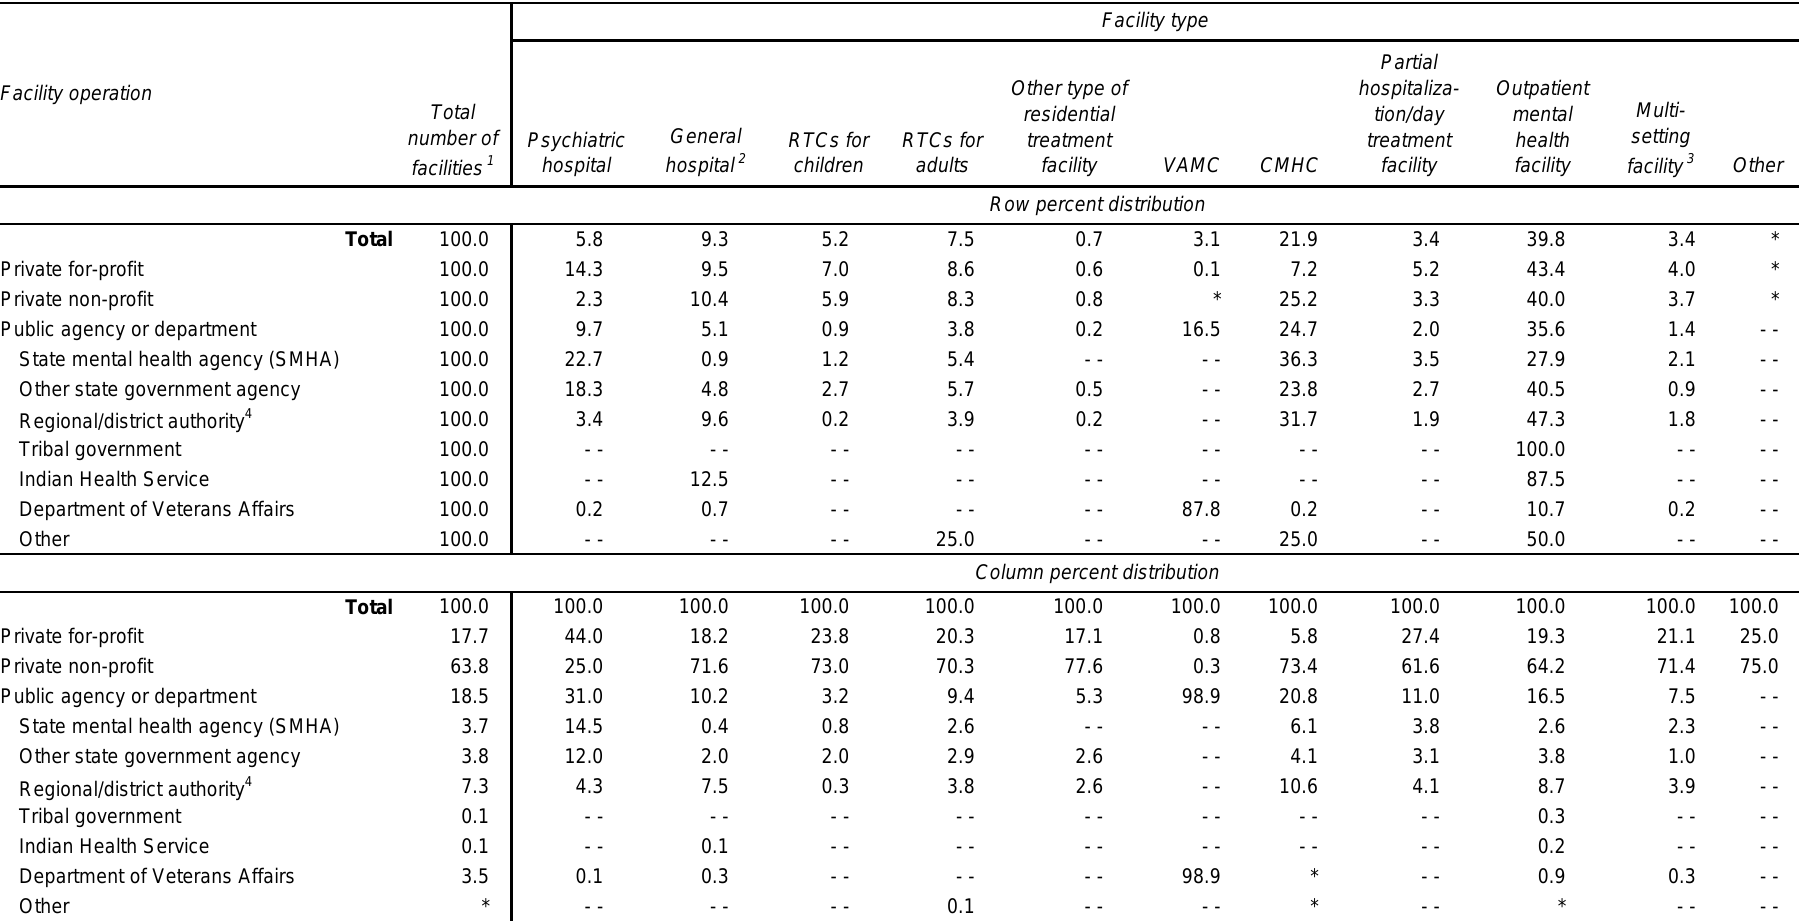
Table 2.2b. Mental health treatment facilities, by facility type and facility operation: Row and column percent,